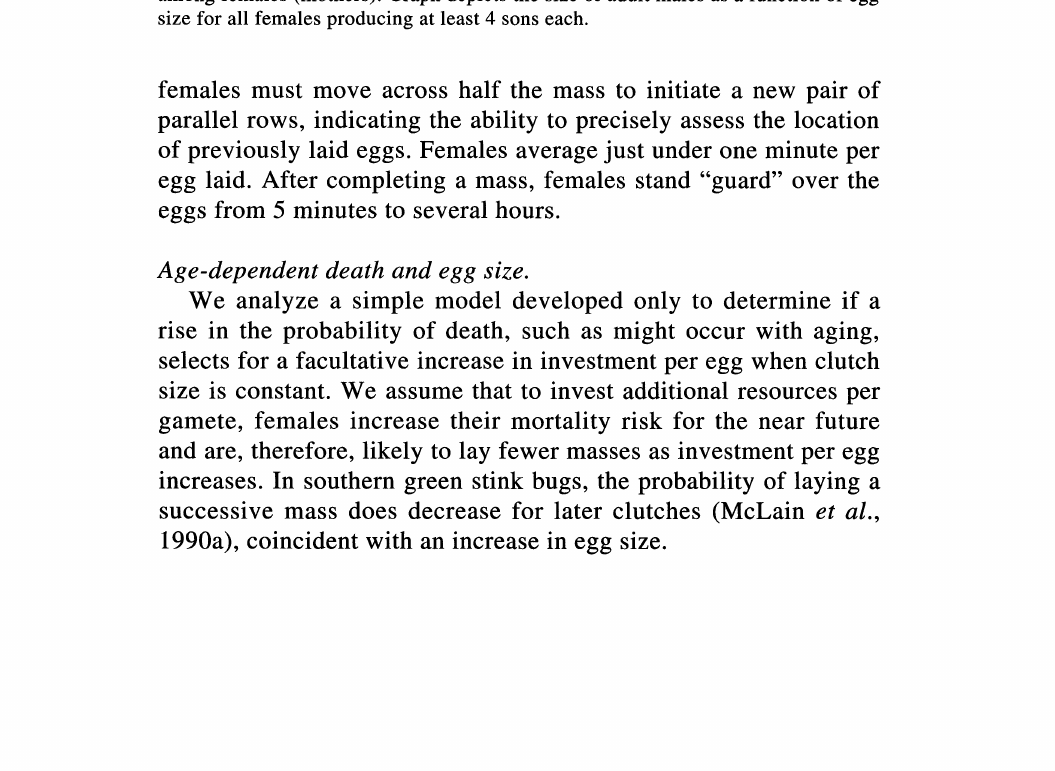
Figure 8. Illustration that the correlation between egg size and adult size varies among females (mothers). Graph depicts the size of adult males as a function of egg size for all females producing at least 4 sons